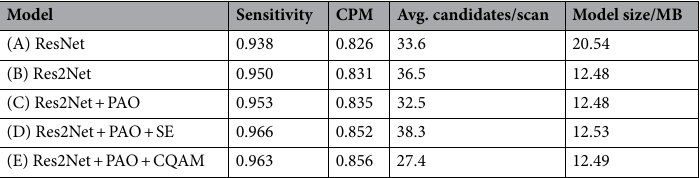
Table 1. Performance comparison of different candidate nodule detection